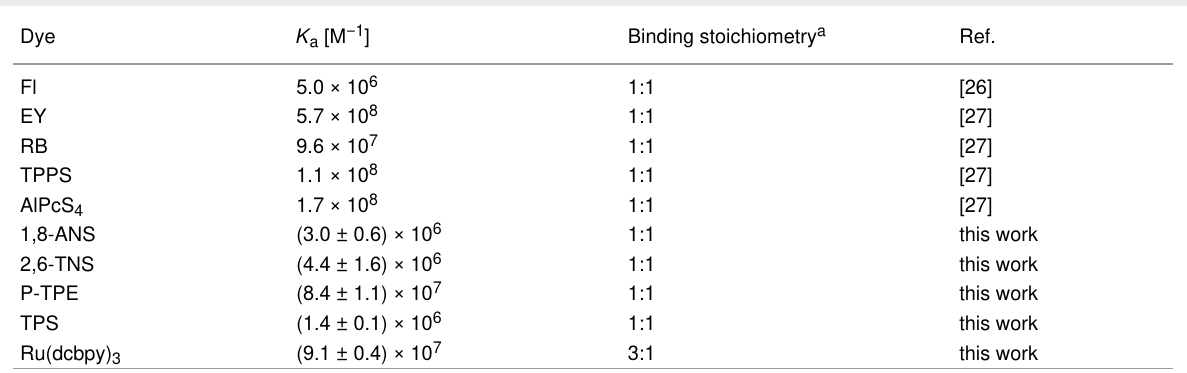
Table 1: Binding constants and binding stoichiometries of GC5A–dye complexes. Dye K a [M − 1 ] Binding stoichiometry